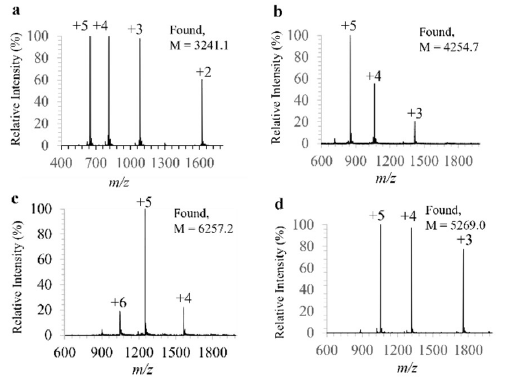
Figure 1. ESI-MS analysis of the synthetic glycopeptides. ( a ) glycopeptide 5 ; ( b ) glycopeptide 8 ; ( c ) glycopeptide 10 ; ( d ) glycopeptide 11 .